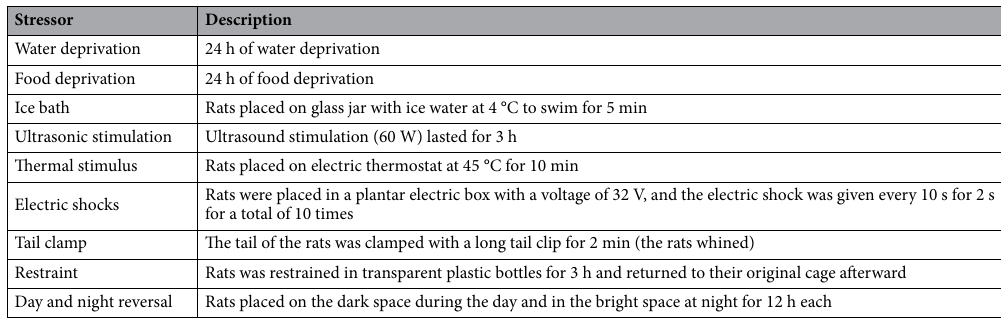
Table 2. The applied stressors of CUMS. CUMS; chronic unpredictable mild